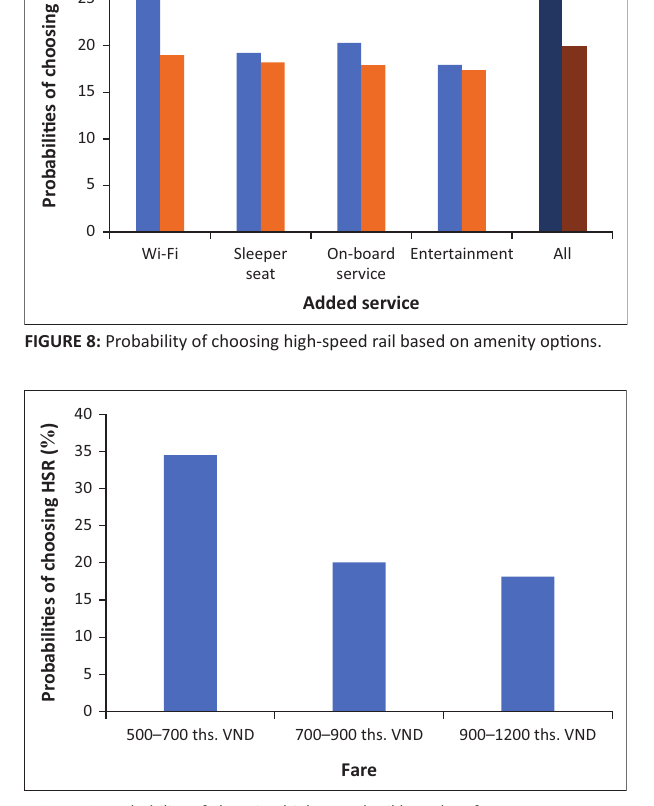
FIGURE 9: Probability of choosing high-speed rail based on fare.